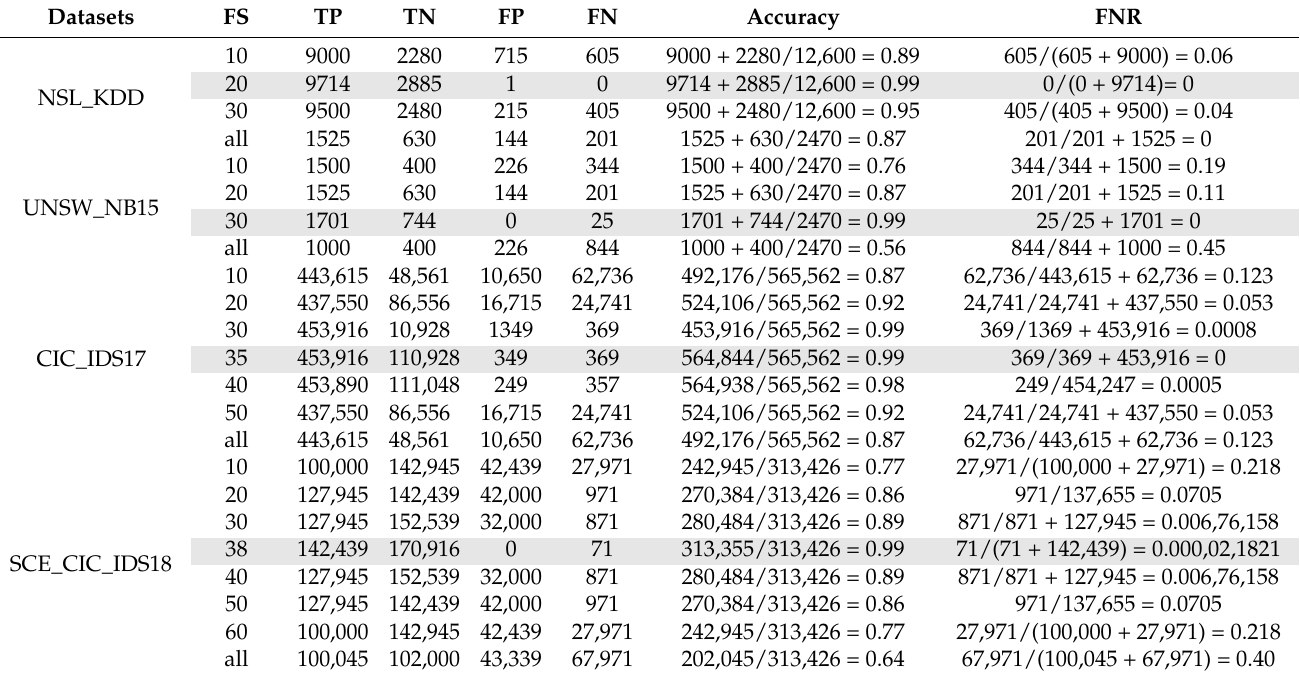
Table 2. Accuracy and FNR for (NSL_KDD, UNSW_NB15, CIC_IDS17, and SCE_CIC_IDS18) datasets when applied to different FSs.